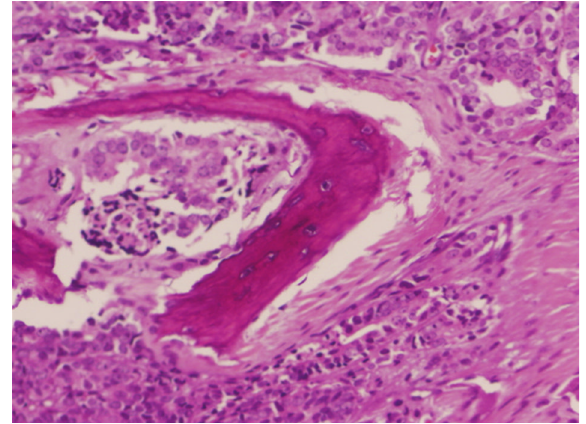
Figure 3: In this figure, the cellular invasion of the sinusal bone can be